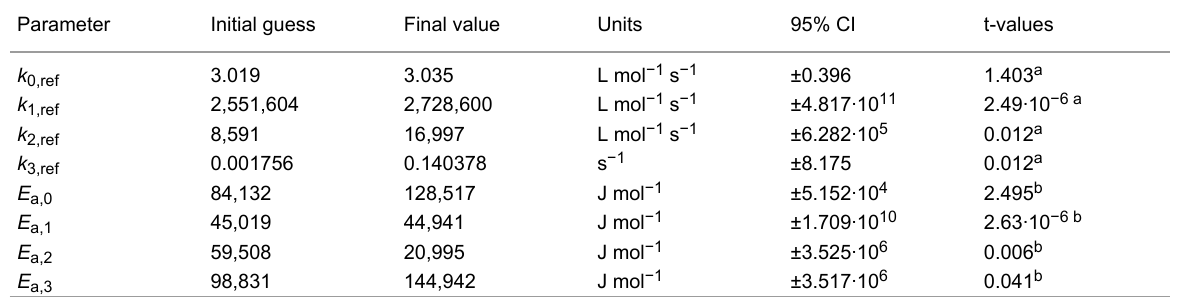
Table 3: Results of the parameter estimation showing the final values, initial guesses, 95% confidence intervals (CI) and t-values for each of the 8 pa- rameters. Parameter